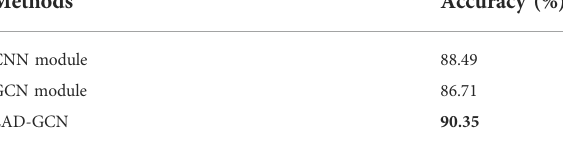
TABLE 2 Comparison of the performances of each module in terms of